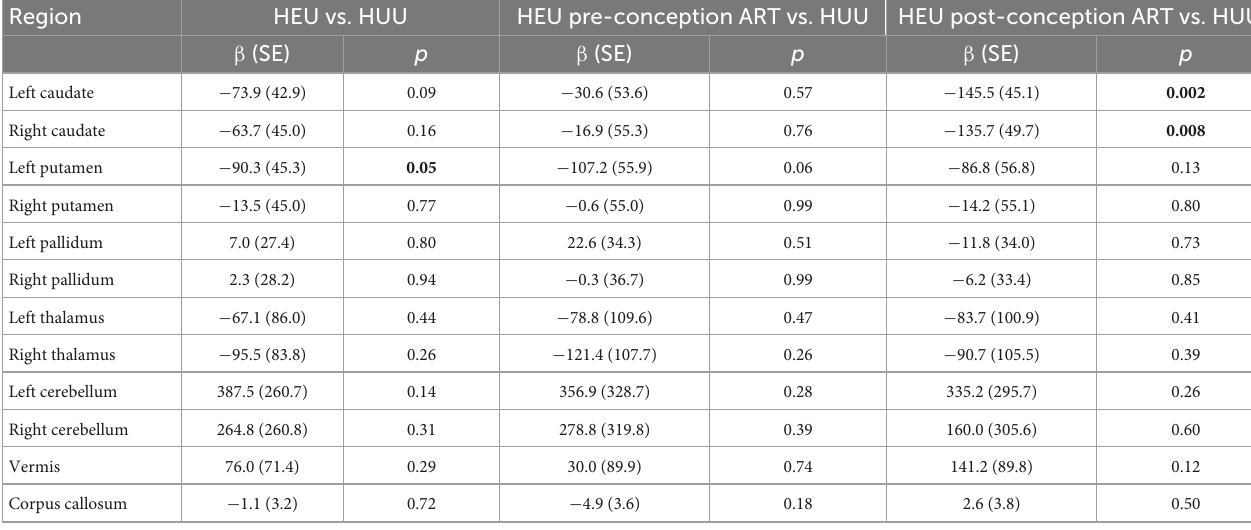
TABLE 3 Regression coefficients for the effect of group on regional volumes, controlling for potential confounding by covariates at least weakly related to any volumetric outcome. Region HEU vs. HUU HEU pre-conception ART vs. HUU HEU post-conception ART vs.